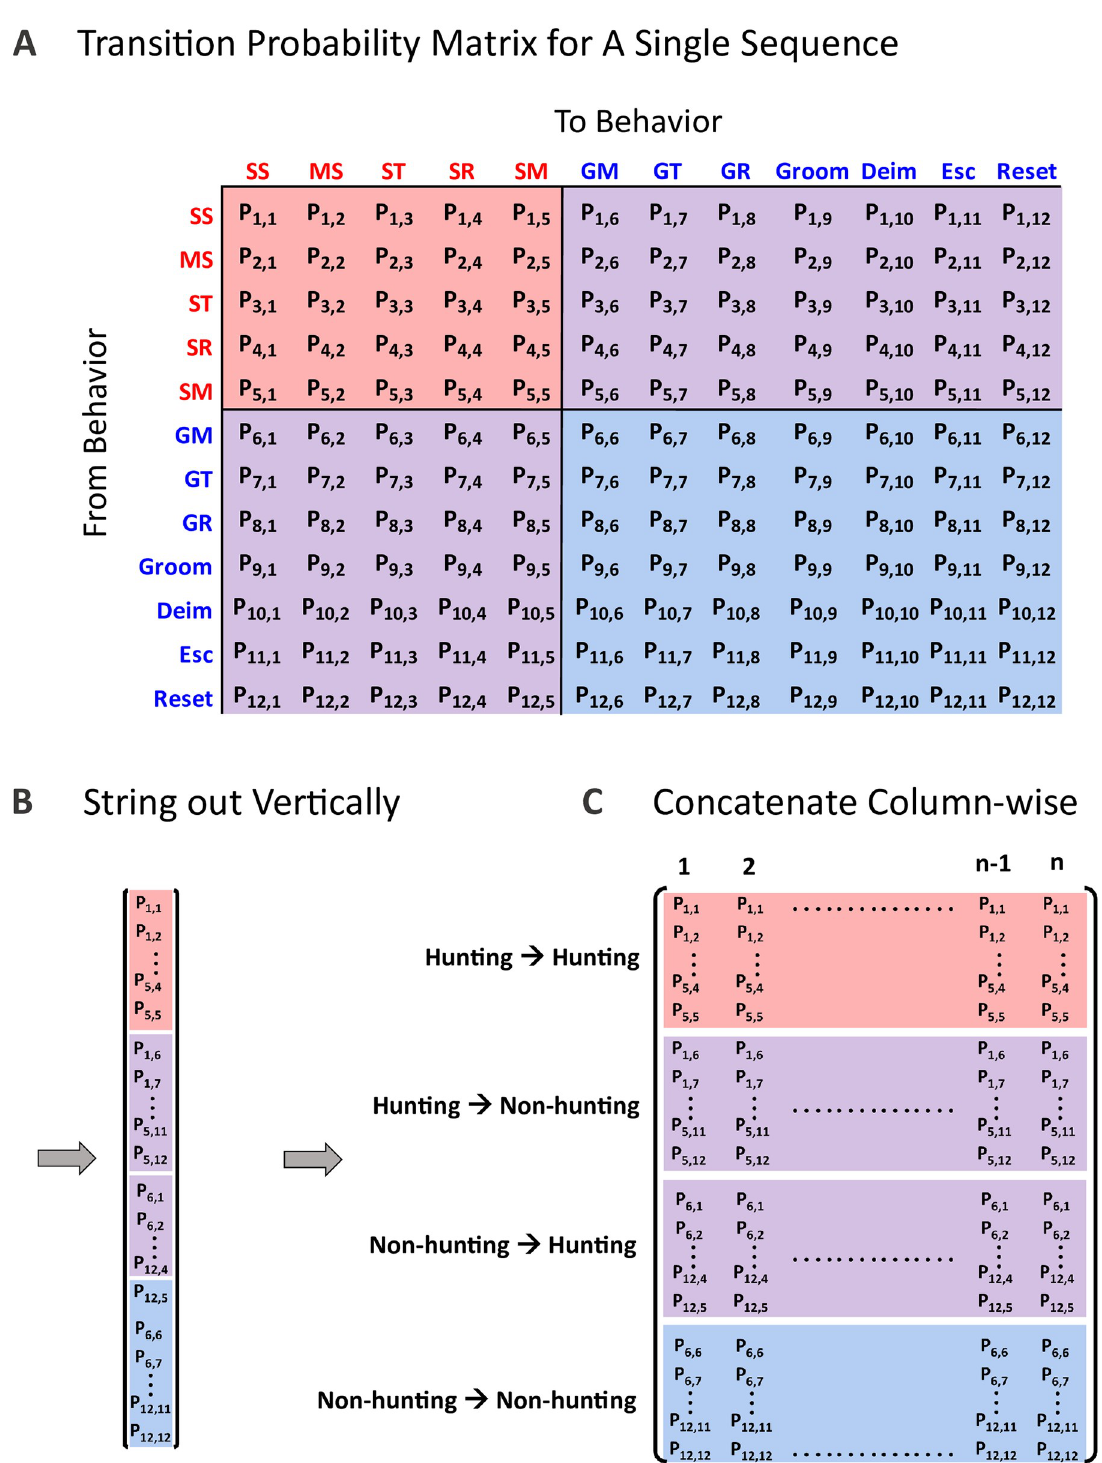
Fig 4. Transition Probability Matrix. (A) Example organization of the square transition probability matrix. The probability, P , of transitioning out of behavior i to behavior j is held in the matrix element, i , j . For example, P 3,1 represents the observed probability of the animal transitioning from behavior 3 (specific translation, ST) to behavior 1 (successful strike, SS). The color coding seen in (A) denotes the regime in which each behavior belongs (red = hunting regime behaviors; blue = nonhunting behaviors). The red shaded region of the square matrix corresponds to the probabilities of hunting behaviors further transitioning into hunting behavior. The purple regions show